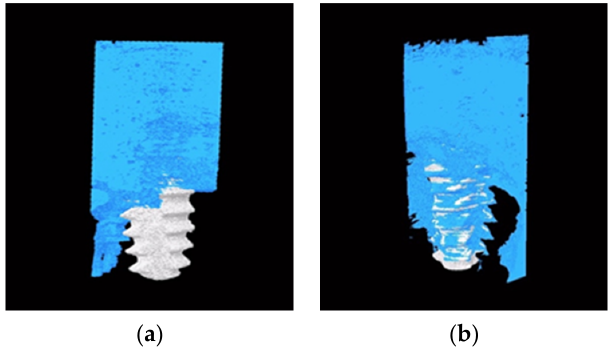
Figure 1. The reconstructed 3D images showing dental implants (white) and peri-implant bone tissue (blue) after 4 weeks of implantation. ( a ) Implant placement without nacre powder. ( b ) Implant placement with nacre powder.